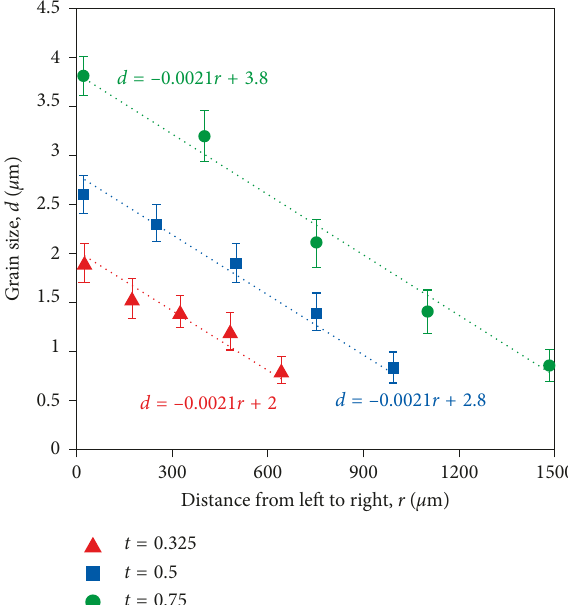
Figure 5: Variation of grain size within the fin for three values of the fin thickness ratio t .